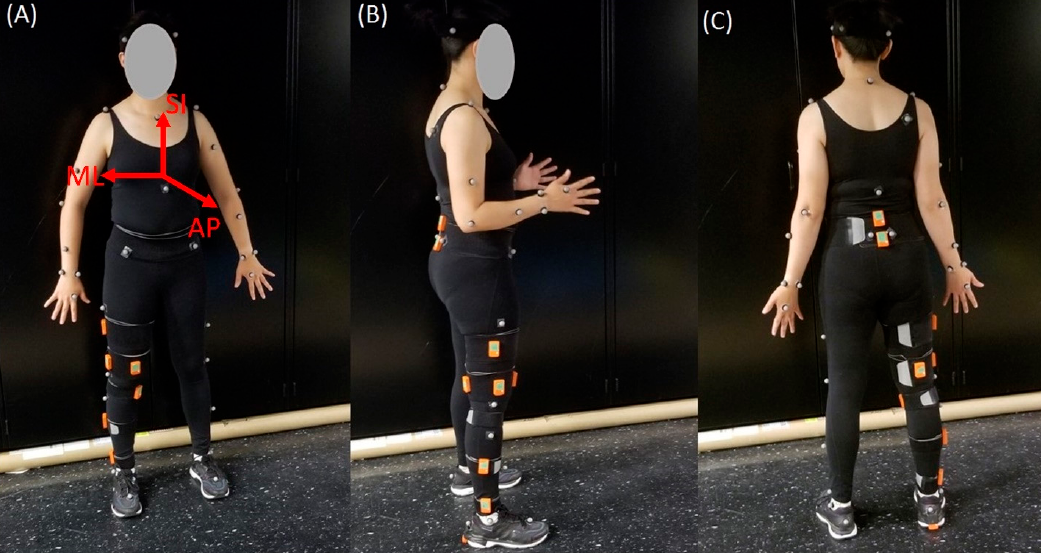
Figure 1. Participant set-up. Depiction of the location of each IMU sensor (orange) and Plug-In-Gait body model marker locations for: ( A ) the front view; ( B ) the side view; and ( C ) the back view. Orientations of the superior–inferior (SI), medial–lateral (ML), and anterior–posterior (AP) axes are also shown in ( A ).